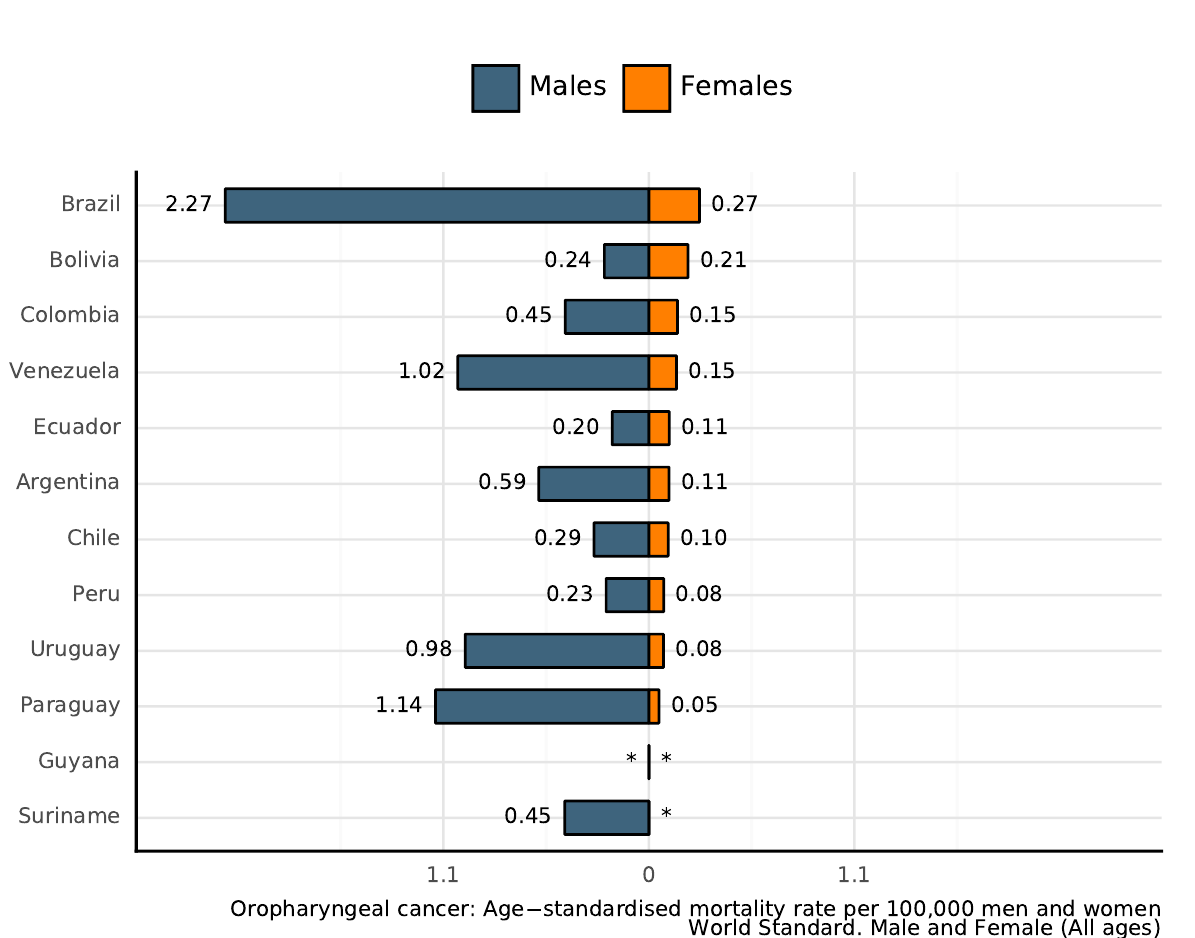
Figure 122: Age-standardised mortality rates of oropharyngeal cancer of Peru (estimates for 2020)